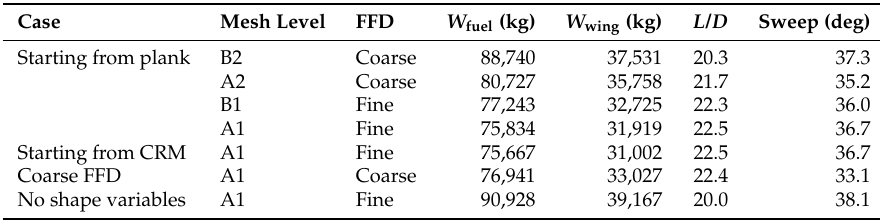
Table 6. Results of single-point